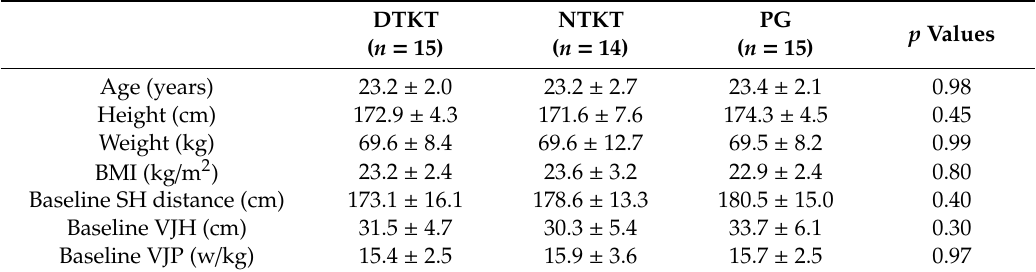
Table 1. General characteristics of participants ( N = 44).